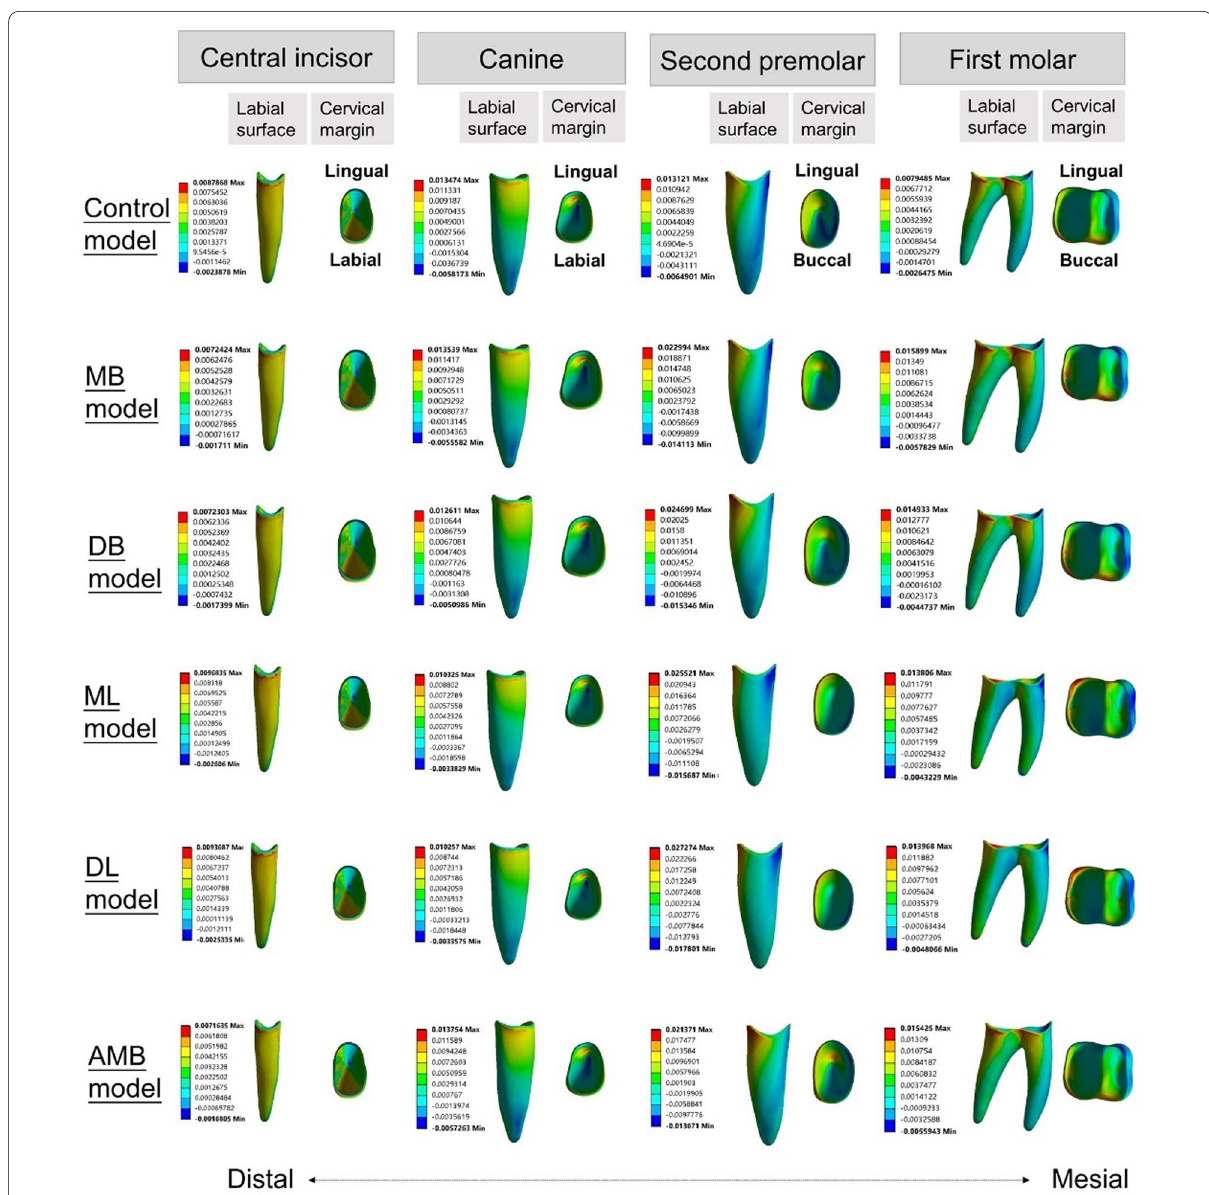
Fig. 8 Maximum principal stress distribution of PDL in six models